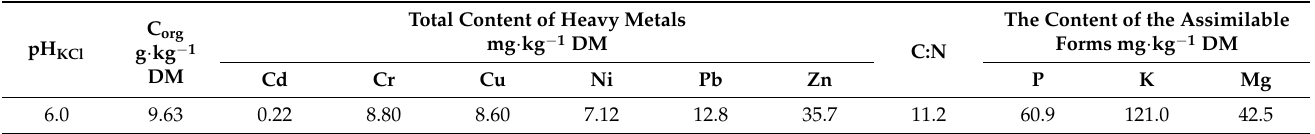
Table 4. Indicators of soil fertility before setting up the experiment